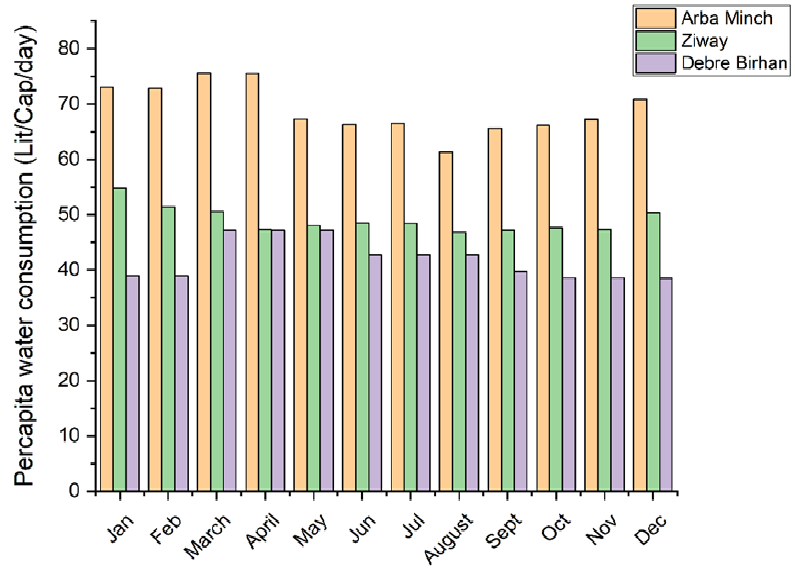
Figure 3. Average per capita water consumption distribution of 2012 to 2020 study period.